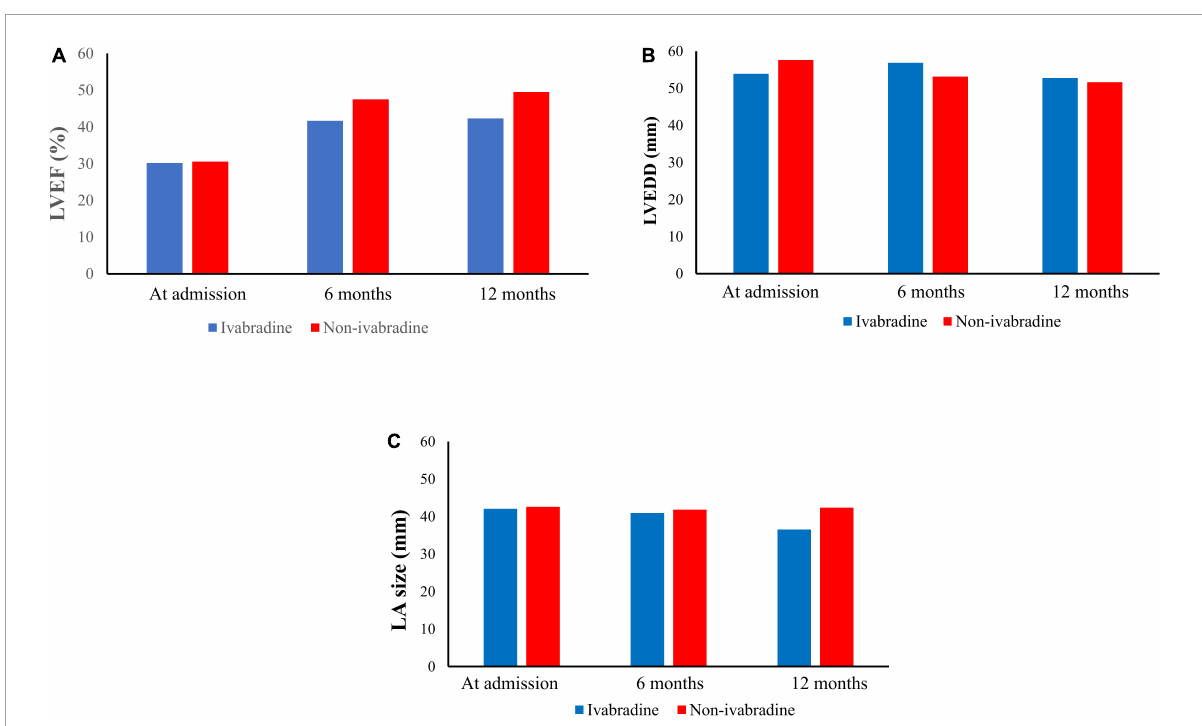
FIGURE5 Echocardiographic parameters during the observation period. After discharge, there were 168 patients received echocardiogram in ivabradine group while 1,648 patients received echocardiogram in non-ivabradine group in our observation period. In echocardiographic result, it showed that improvements in left ventricular ejection fraction (LVEF) (A) were seen in both groups. However, there were no significant differences in LVEF (A) , left ventricular end-diastolic diameter (B) , and left atrium size (C) after inverse probability of treatment weighting without